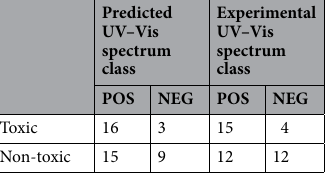
Table 8. Confusion matrices relating RF-predicted and experimental UV–Vis spectrum class with the 3T3 NRU phototoxicity in vitro